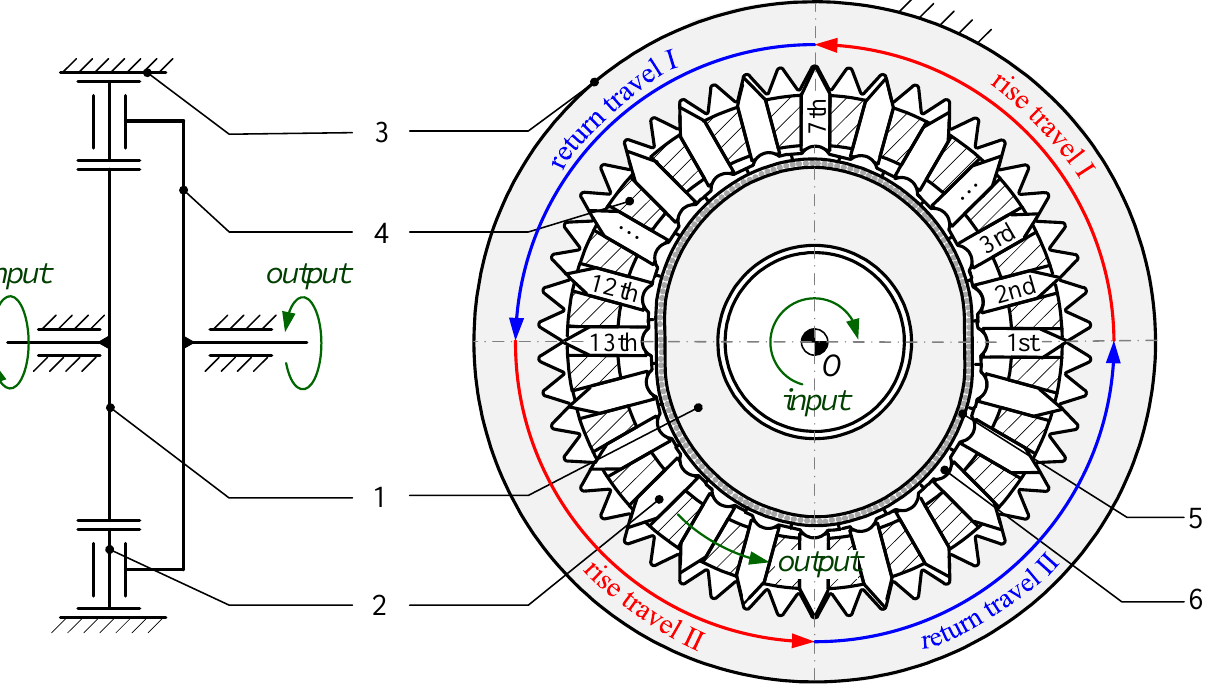
Figure 1. Schematic diagram of the novel movable tooth drive. 1-wave generator; 2-tooth carrier; 3-ring gear; 4-movable tooth; 5-needle roller; 6-pivoted segment.